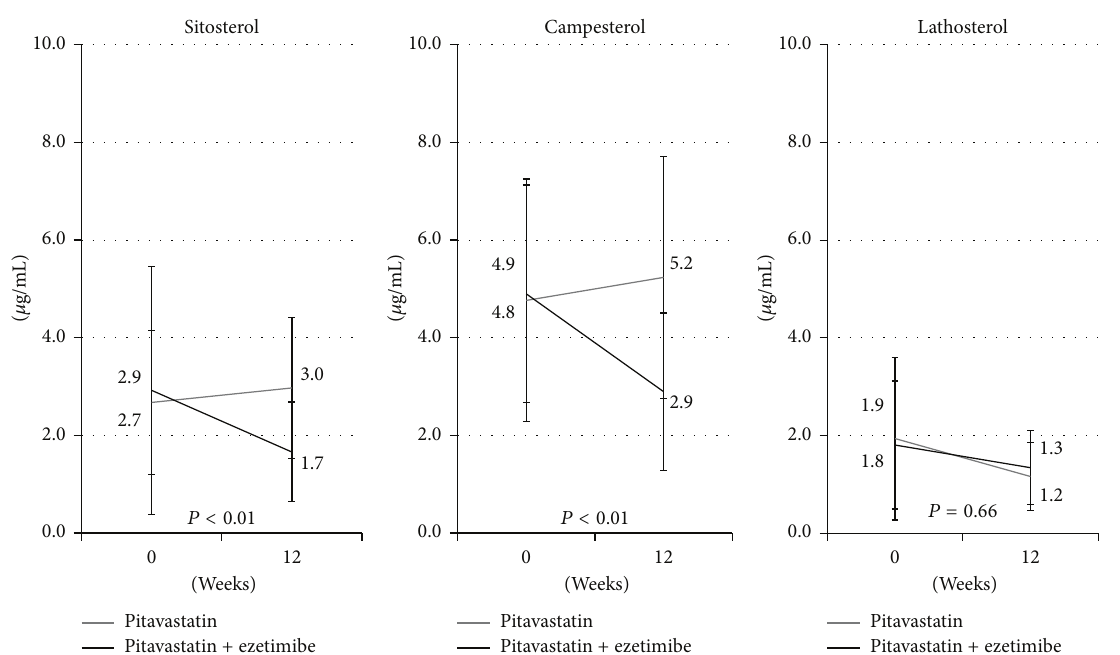
Figure 2: After 12 weeks of treatment, the serum levels of sitosterol and campesterol show a significant decrease in the pitavastatin + ezetimibe group compared to the pitavastatin group. The serum level of lathosterol decreases in both groups, but there is no significant difference between the two groups.